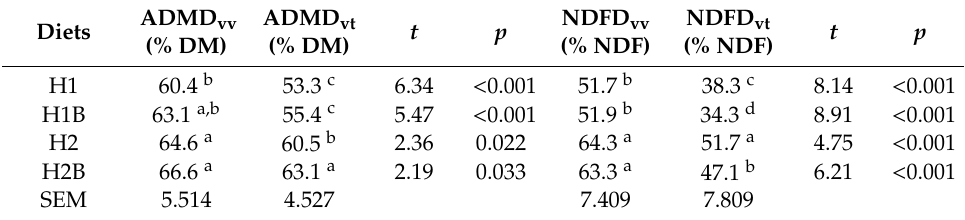
Table 2. E ff ect of diet on in vivo and in vitro dry matter and neutral detergent fiber digestibility. Comparison between in vivo and in vitro dry matter digestibility (ADMD vv vs ADMD vt ) and neutral detergent fiber digestibility (NDFD vv vs NDFD vt ) for each